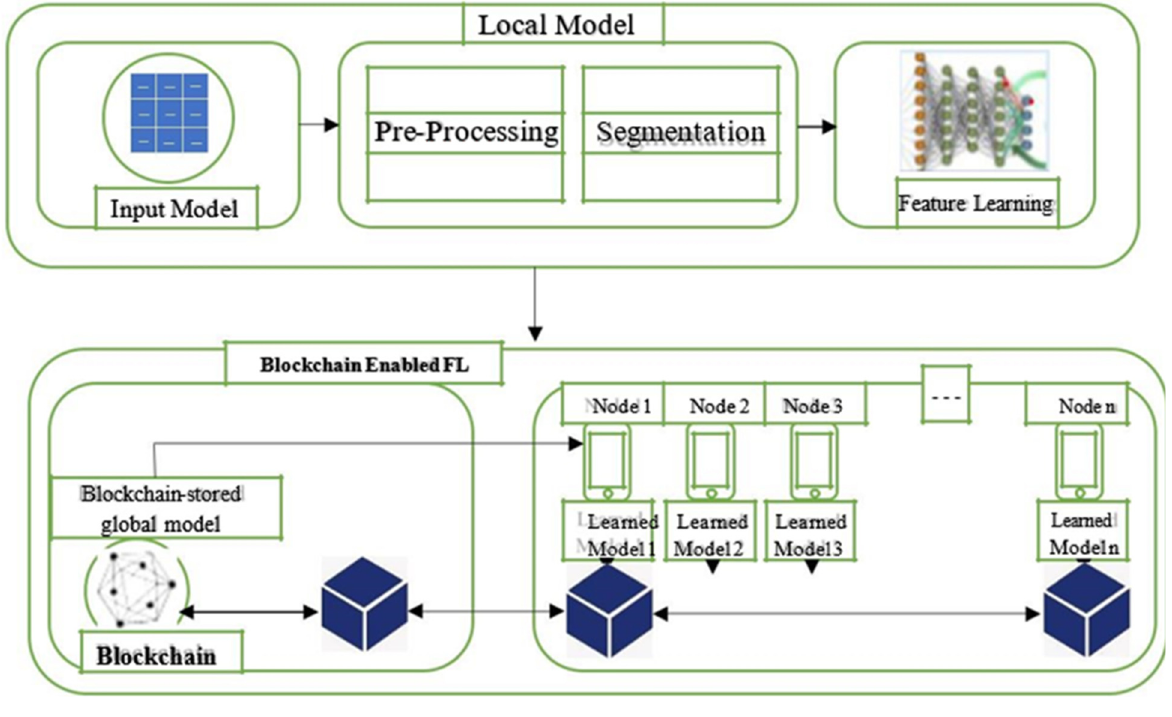
Figure 1. System